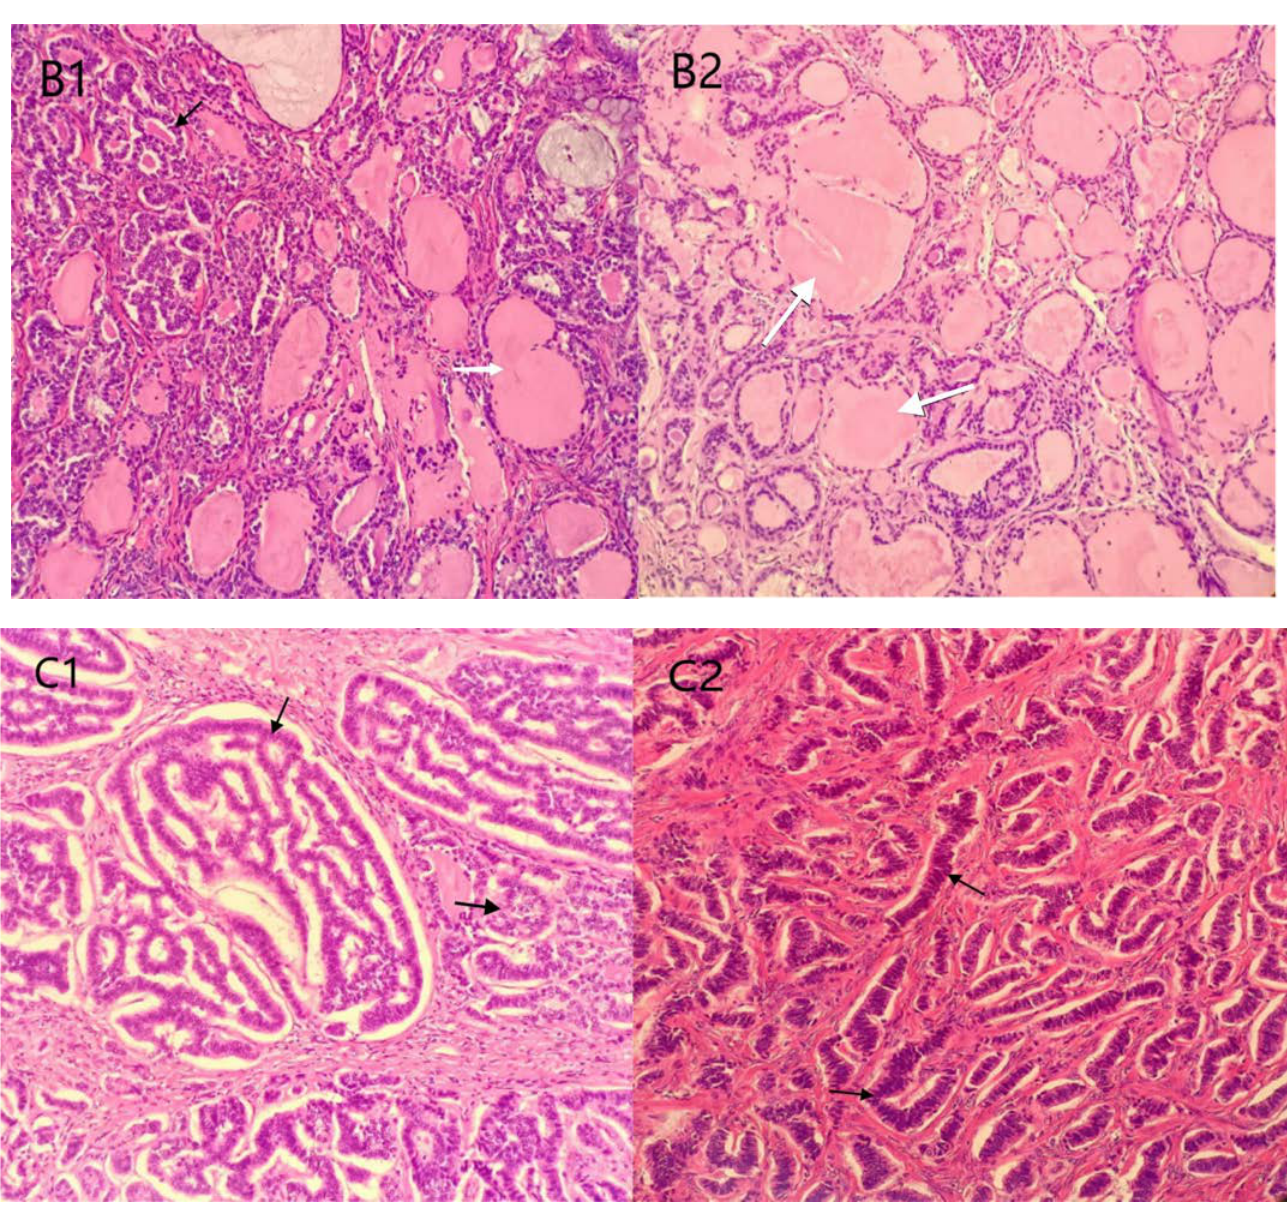
Figure 2. Mature cystic teratoma: stratified squamous epithelium with skin appendages, mature neuronal elements and fat tissue; ( A1 ): Mature cystic teratoma (colonic gland), H&E × 100; ( A2 ): Mature cystic teratoma (skin and cutaneous appendages), H&E × 40. ( B1 ): carcinoid components: cancer cells are arranged in trabecular, ribbon, and adenoid patterns, locally nested or insular, tumor cells are uniform and consistent, cytoplasm is abundant and eosinophilic, nuclei are round and centered, nuclear chromatin is uniform and coarse particles, and mitotic figures are rare can be seen in the tumor parenchyma (black arrow). ( B2 ): strumal components: thyroid follicles of different sizes, follicles lined by a single layer of flat epithelium or cuboidal epithelium, follicles containing eosinophilic material (white arrow). ( C1 ): carcinoid components (glandular, nested, island-like structure), H&E × 200. ( C2 ): carcinoid components (small bright, cable shape, ribbon-like structure), H&E × 200.